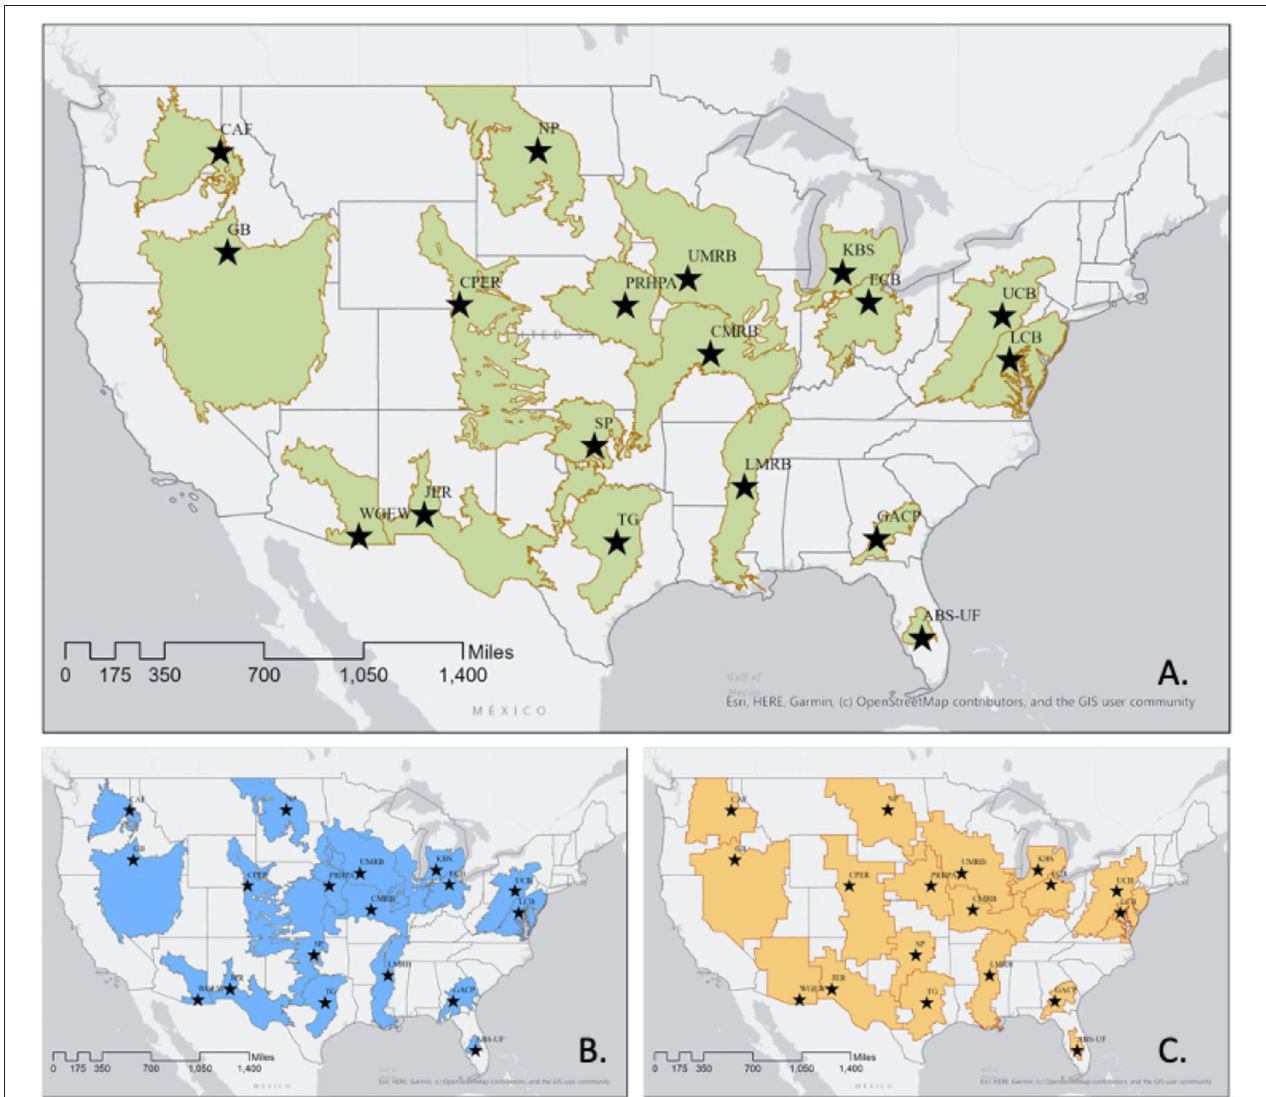
FIGURE 1 | Maps of current Long-Term Agroecosystem Research (LTAR) agroecoregions. (A) Production Boundaries; (B) Environment Boundaries; and (C) Rural Prosperity Boundaries. LTAR sites from west to east: CAF, R.J. Cook Agronomy Farm in Pullman, WA; GB, Great Basin in Boise, ID; WGEW, Walnut Gulch Experimental Watershed in Tucson, AZ; JER, Jornada Experimental Range in Las Cruces, NM; CPER, Central Plains Experimental Range in Nunn, CO; NP, Northern Plains in Mandan, ND; SP, Southern Plains in El Reno, OK; TG, Texas Gulf in Temple, TX; PRHPA, Platte River/High Plains Aquifer in Lincoln, NE; UMRB, Upper Mississippi River Basin in Ames, IA; CMRB, Central Mississippi River Basin in Columbia, MO; LMRB, Lower Mississippi River Basin in Oxford, MS; KBS, Kellogg Biological Station in Hickory Corners, MI; GACP, Gulf Atlantic Coastal Plain in Tifton, GA; ECB, Eastern Corn Belt in Columbus, OH; ABS-UF, Archbold-University of Florida in Venus, FL; UCB, Upper Chesapeake Bay in University Park, PA; LCB, Lower Chesapeake Bay in Beltsville,